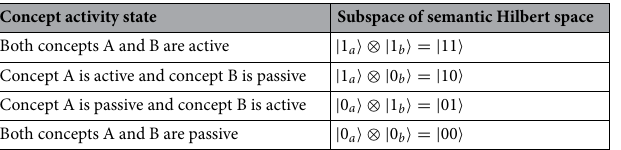
Table 1. Two-dimensional Hilbert space of semantic categories defining text perception based on concepts A and B